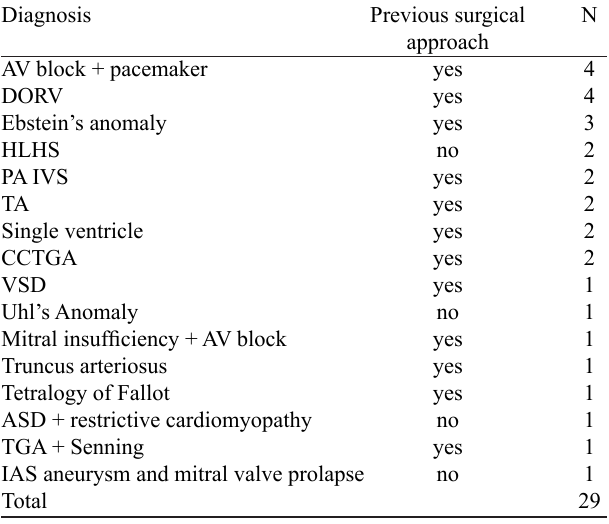
Table 1. Diagnosis and previous surgical approach in patients with congenital heart